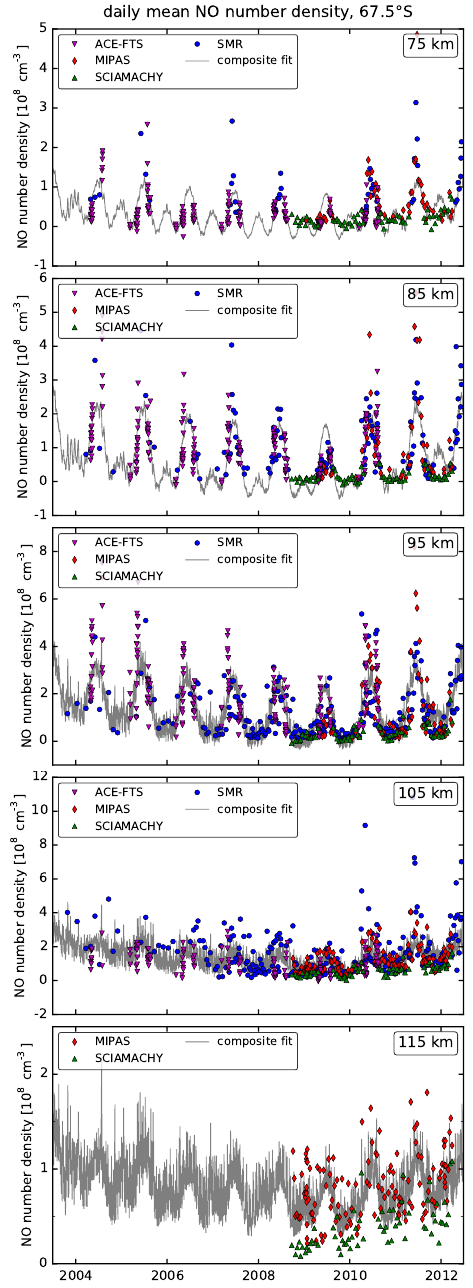
Figure C2. NO time series regression results at 67.5 ◦ S, for 75km, 85km, 95km, 105km, and 115km (from top to